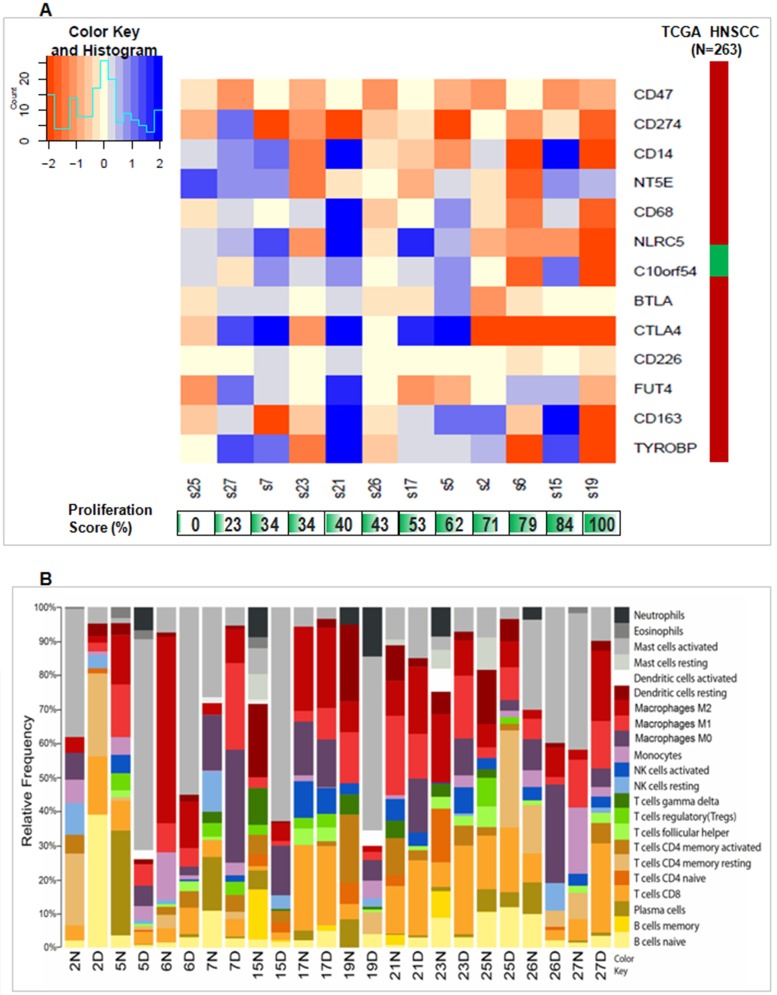
Immune response alterations in tumor compared to normal tissues.(A) Heatmap shows diverse expression levels (log fold change of FPKM values) of immune evasion genes. Orange values in color bar shows up regulation while values in blue show down regulation. The panel below shows proliferation scores per samples with green color intensity indicating higher proliferation score and numbers indicates % CCP score. The right-side panel indicates fold change values (FPKM) in TCGA HNSCC cohort (n = 263) for each gene. In case of TCGA HNCC tissues, Green color denotes downregulation while red color shows upregulation in the right-side panel. (B) The barplot shows how relative composition of immune cells is altered across 12 pairs of tumor compared to its control tissues. Plot was derived from the CIBERSORT [9] estimated data output from FPKM normalized expression data. Every color stands for a type of immune cell and height of each colored bar represents relative frequency of an immune cell type. In the plot, 2N and 2D indicate normal and tumour tissues of tumour-normal paired S2sample, respectively. Similar nomenclature was used for tumour and normal tissues of other samples.